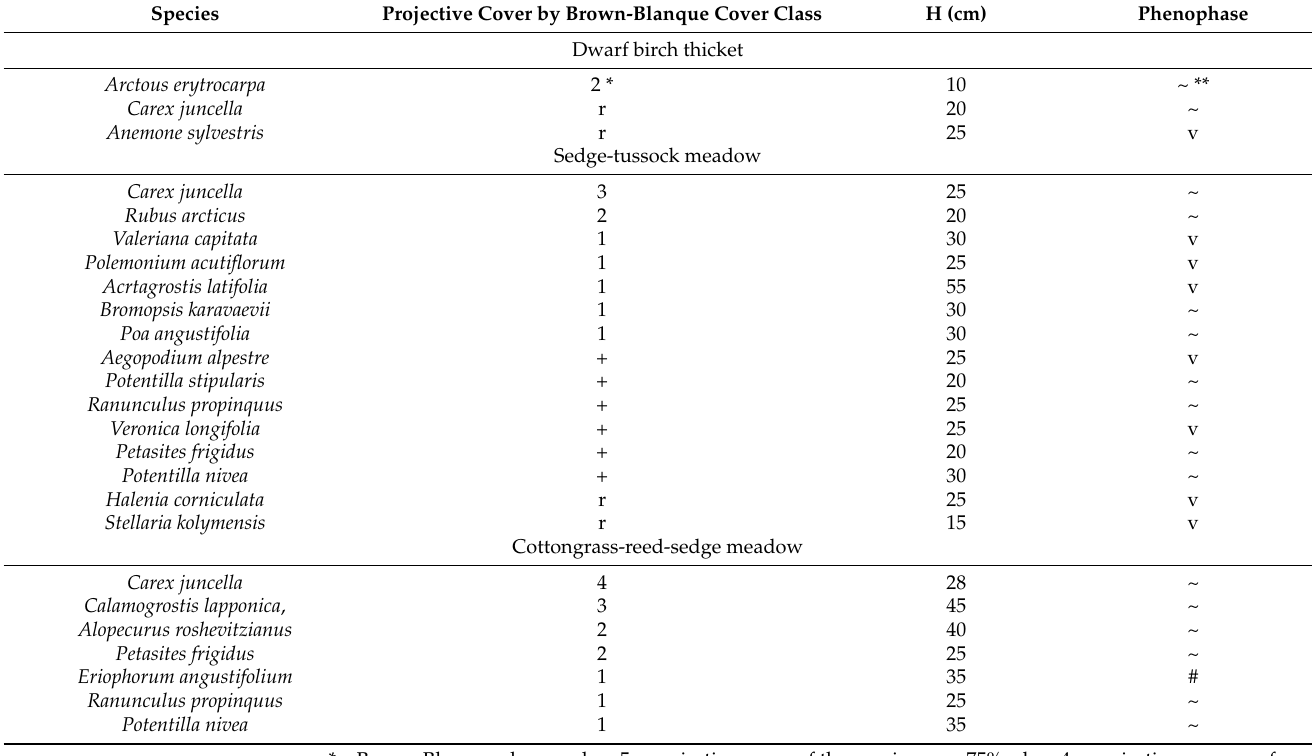
Table 5. The structure of the herbaceous vegetation in